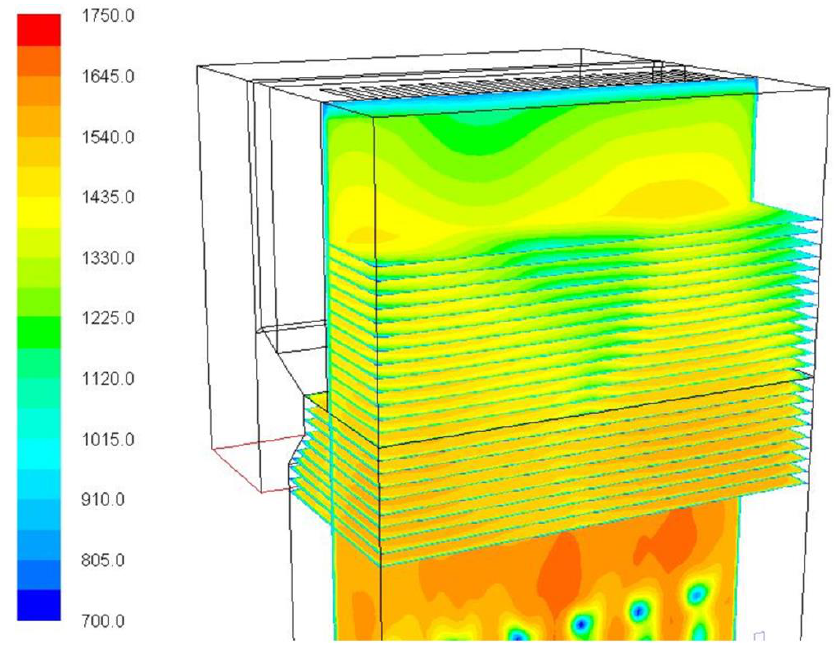
Figure 11. Flue gas temperature (K) in the transverse planes of the chamber.